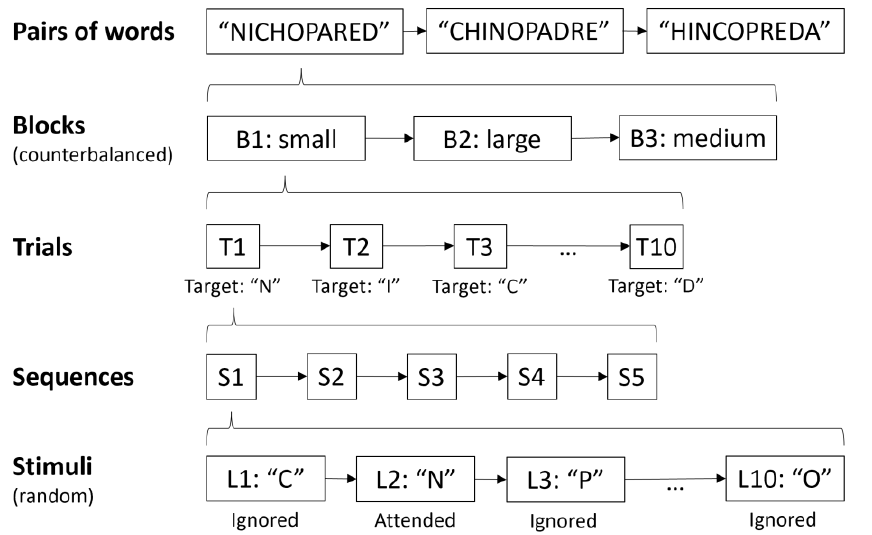
Figure 1. Experimental procedure followed by the participants. The order of the conditions (small, medium, and large) used for each pair of words was counterbalanced for the same participant (i.e., each pair of words had a different order) and between different participants. Likewise, the order of presentation of the stimuli in each sequence was random, without replacement.